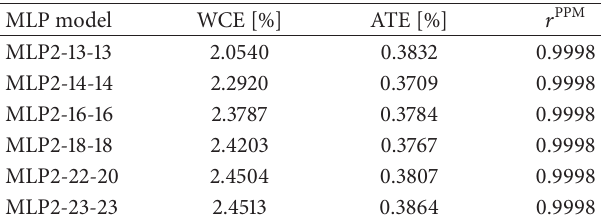
Table 5: Testing results for six MLP-DoA 3 neural network models with the best test statistics.